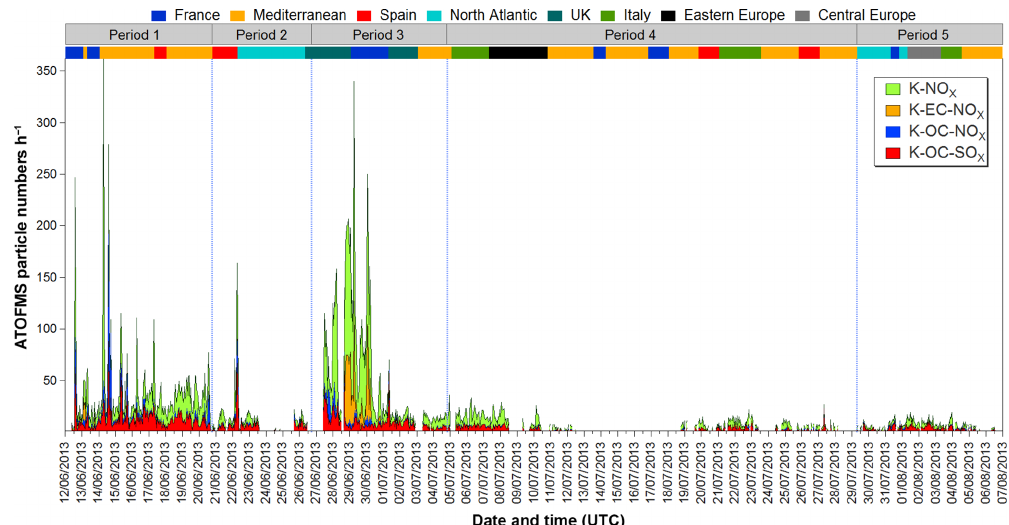
Figure 7. Time series of hourly unscaled particle numbers for ATOFMS particle classes associated with local biomass burning observed during ADRIMED and SAF-MED. Dates are